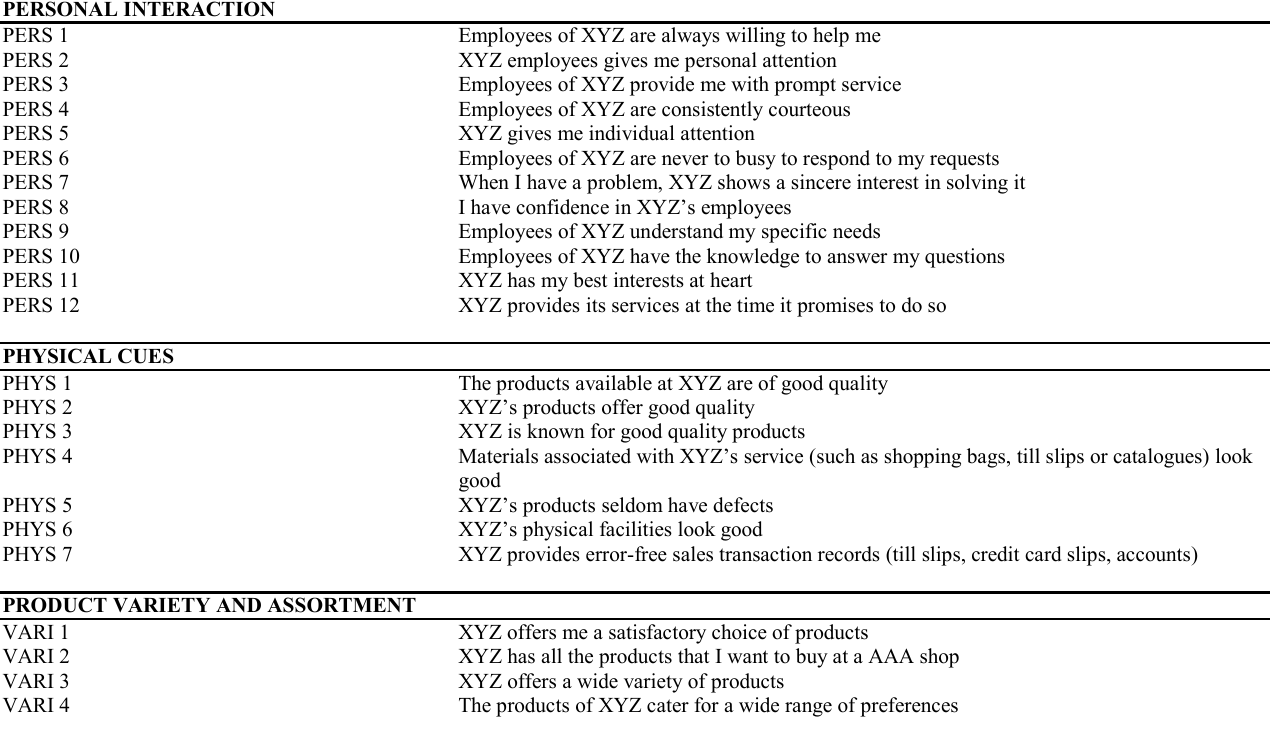
Table 3: Items to measure consumer perceptions of the controllable elements of the total retail experience PERSONAL